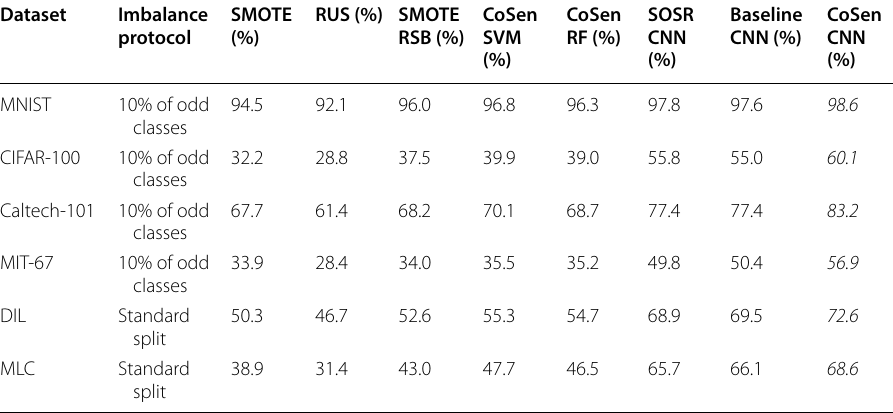
Italic scores indicate the top performance for each data set